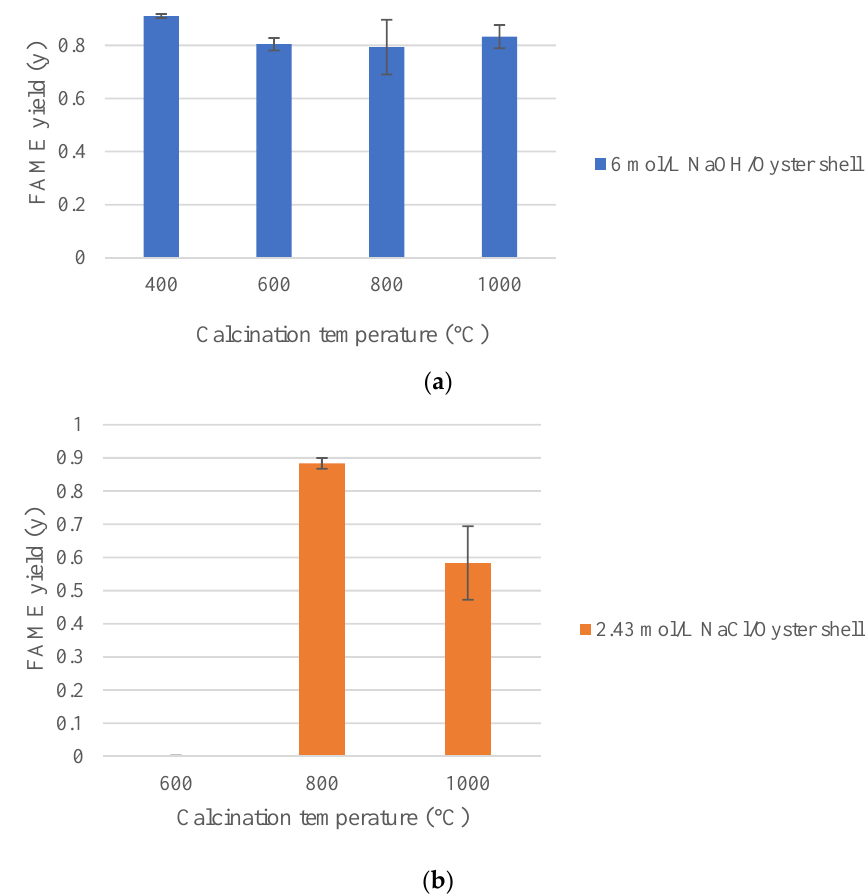
Figure 2. The FAME yield of the transesterification reaction catalyzed by NaOH 6 /shell ( a ) and NaCl 2.43 /shell ( b ) calcined at various temperatures. Transesterification conditions: temperature = 62 ◦ C; stirring rate = 800 rpm; MR = 12; CL =